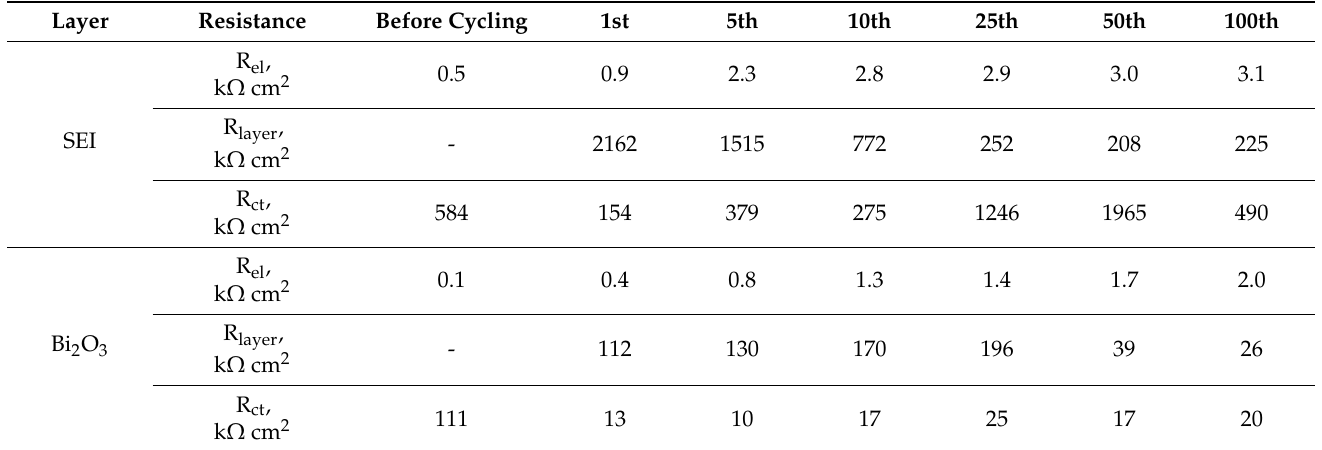
Figure 9. Electrochemical impedance spectroscopy of Bi 2 Se 3 thin films in 5 M LiNO 3 : ( a )—Nyquist plot for the SEI layer ( − 1.0 V ÷ 1.3 V vs. Ag/AgCl), ( b )—Nyquist plot for the Bi 2 O 3 layer ( − 1.0 V ÷ 0.5 V vs. Ag/AgCl), ( c )—equivalent circuit scheme before cycling, ( d )—equivalent circuit scheme during the cycling. Table 3. Cycle-dependent fitted resistance values of Bi 2 Se 3 thin films with SEI and with the Bi 2 O 3 layer.